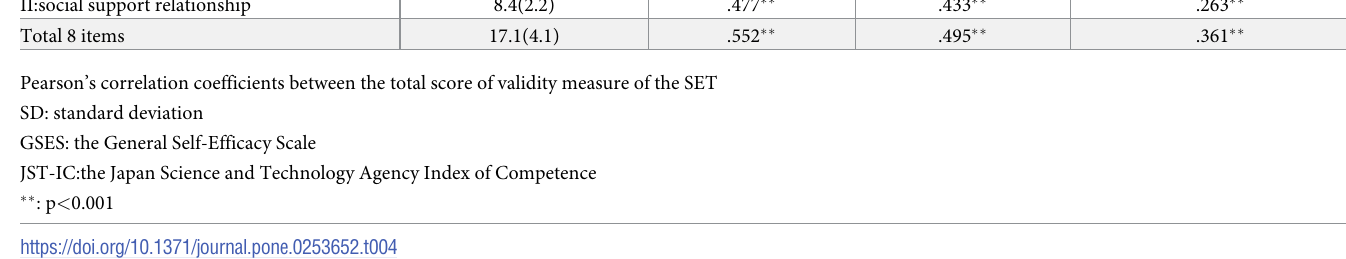
Table 4. Criteria-related validity of “the social contact self-efficacy Scale for Third Agers (SET)”. n = 790 Factors Mean (SD)